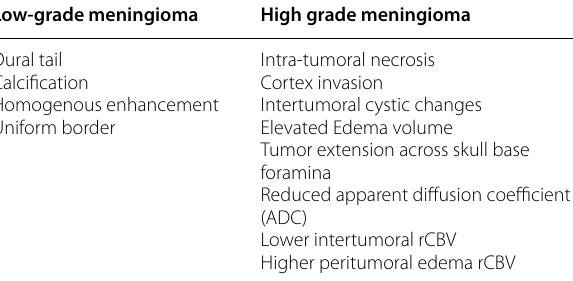
Table 2 Typical MRI radiographic features of